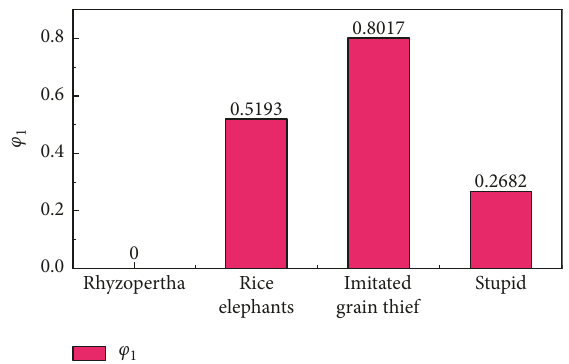
Figure 5: Normalized eigenvalues of identified pests ( φ